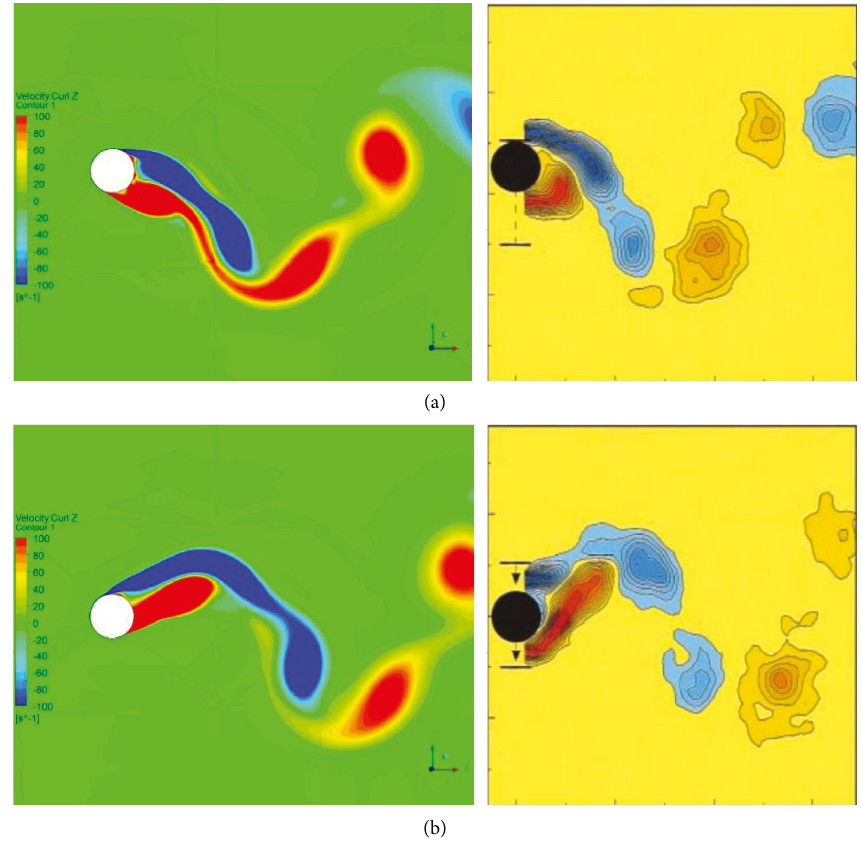
Figure 14: Lower branch showing 2P modes of numerical results at Ur � 8 with m ∗ � 2.4 and A ∗ � 0.637 (left) and PIV measurement results with m ∗ � 8.63 and A ∗ � 0.60 by Govardhan and Williamson [26] (right): (a) cylinder highest position; (b) cylinder zero displacement position when traveling